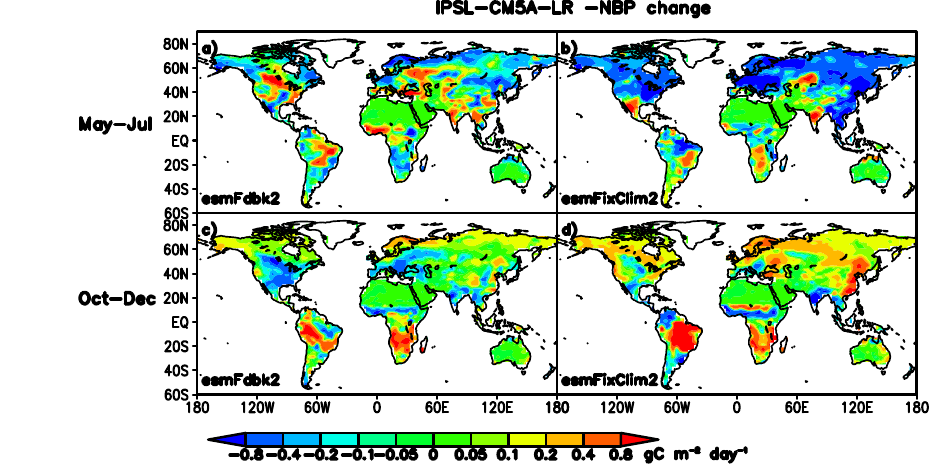
Figure 7. Same as Fig. 6, but for IPSL-CM5A-LR. Both the carbon uptake in peak growing season and net carbon release in dormant season are clearly dominated by changes in atmospheric CO 2 rather than climate for this